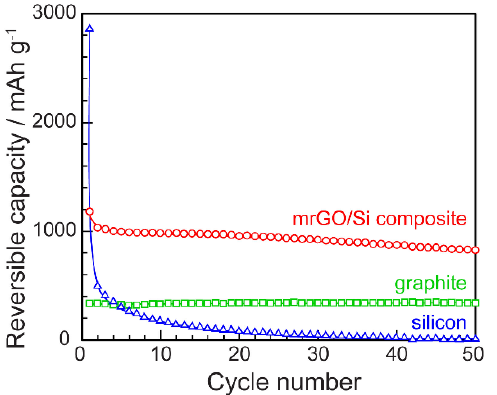
Figure 23. Cyclability of LIBs using the mrGO/Si composite (red), silicon (blue), and graphite (green) as anodes.